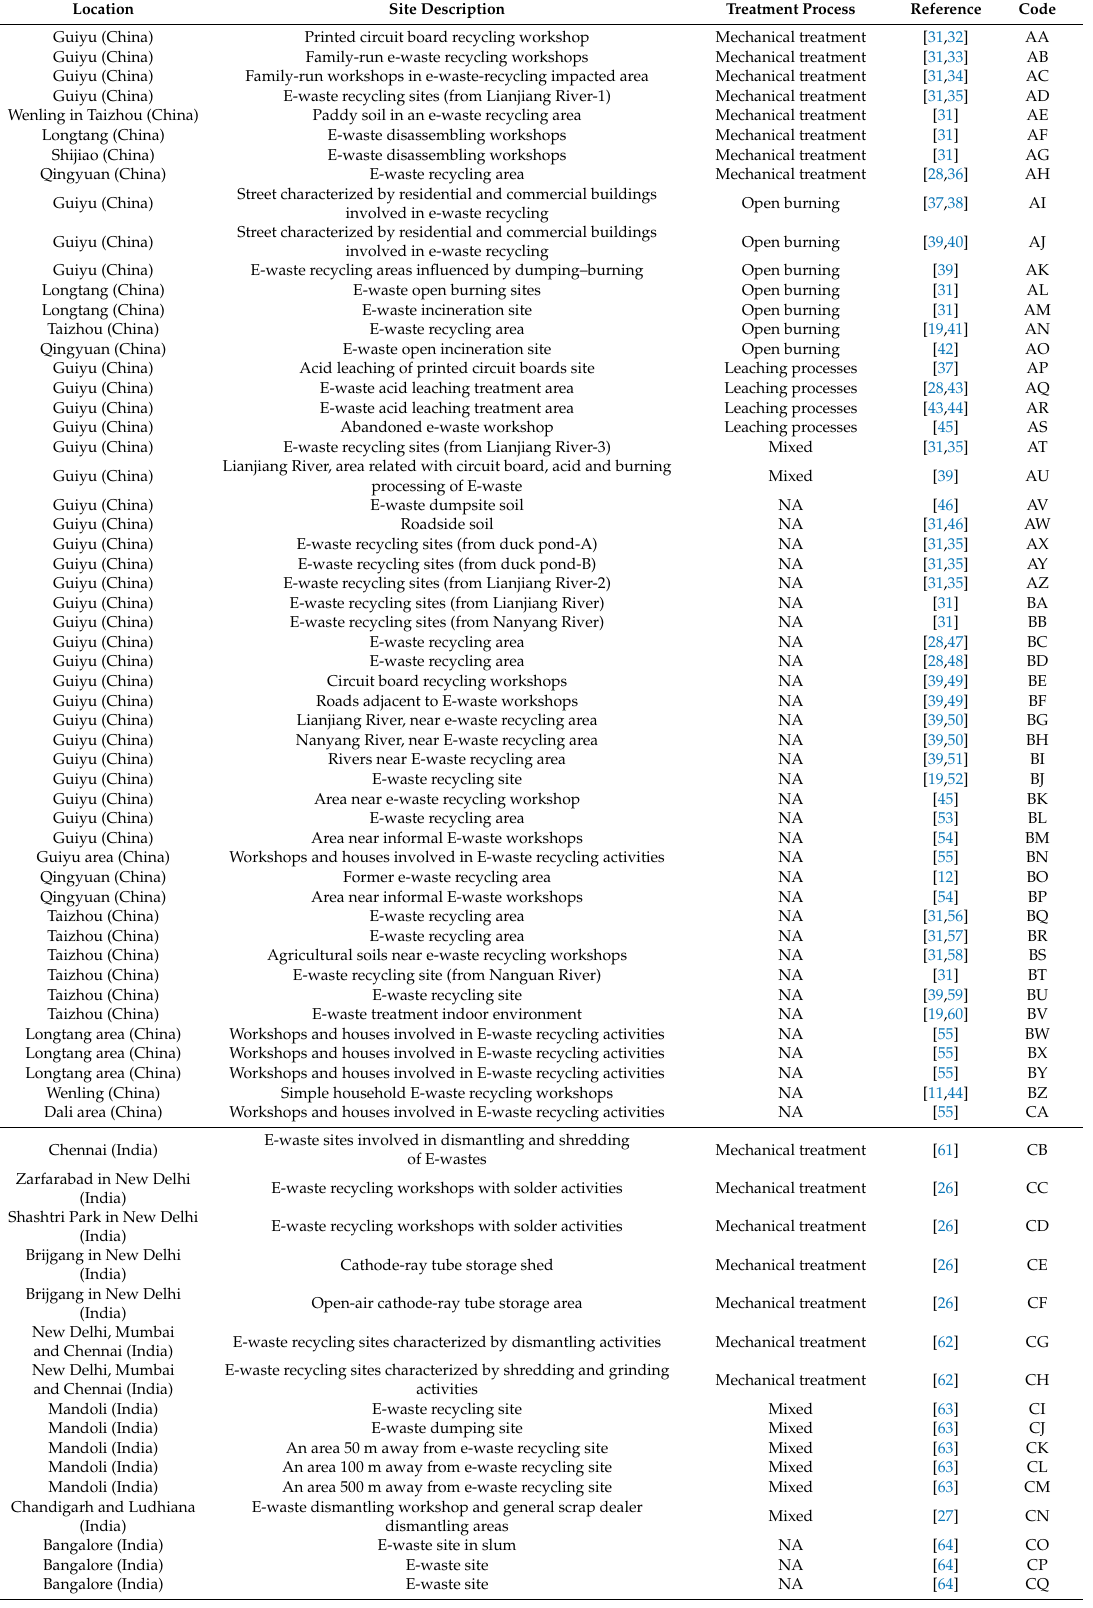
Table 1. Location, site description, treatment process, reference information and code chosen related to informal e-waste treatment in developing countries and areas in the